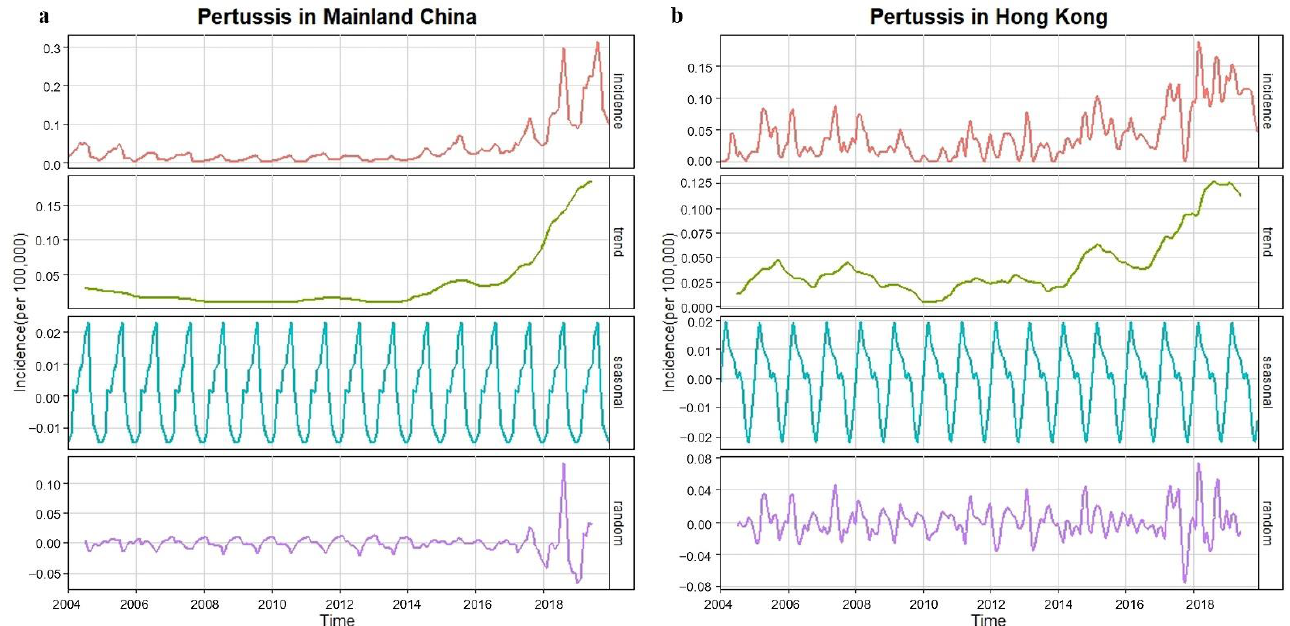
Figure 6. Monthly incidences (1/100,000) in the period 2004 – 2019 of pertussis and long-term trends, seasonal fluctuations, and random fluctuations. ( a ) Pertussis in Mainland China; ( b ) pertussis in Hong Kong.